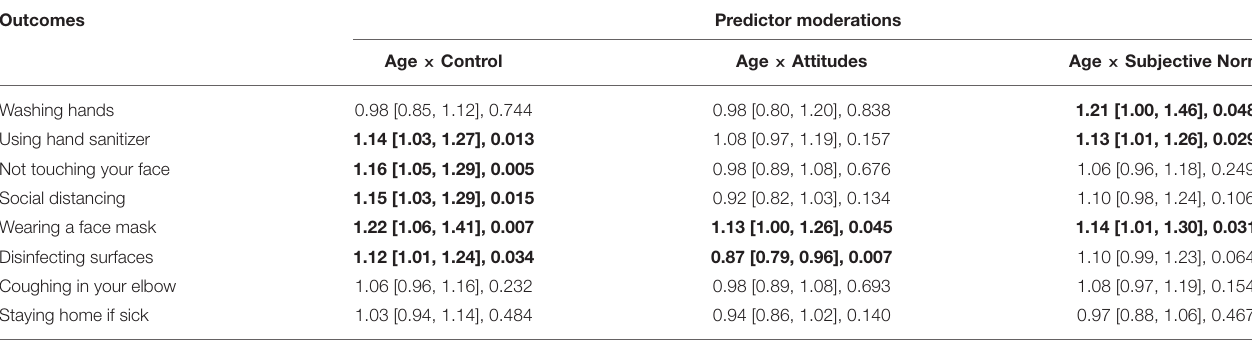
TABLE 3 | Age in years moderating the associations of perceived behavioral control, attitudes, and subjective norm with preventive behaviors.